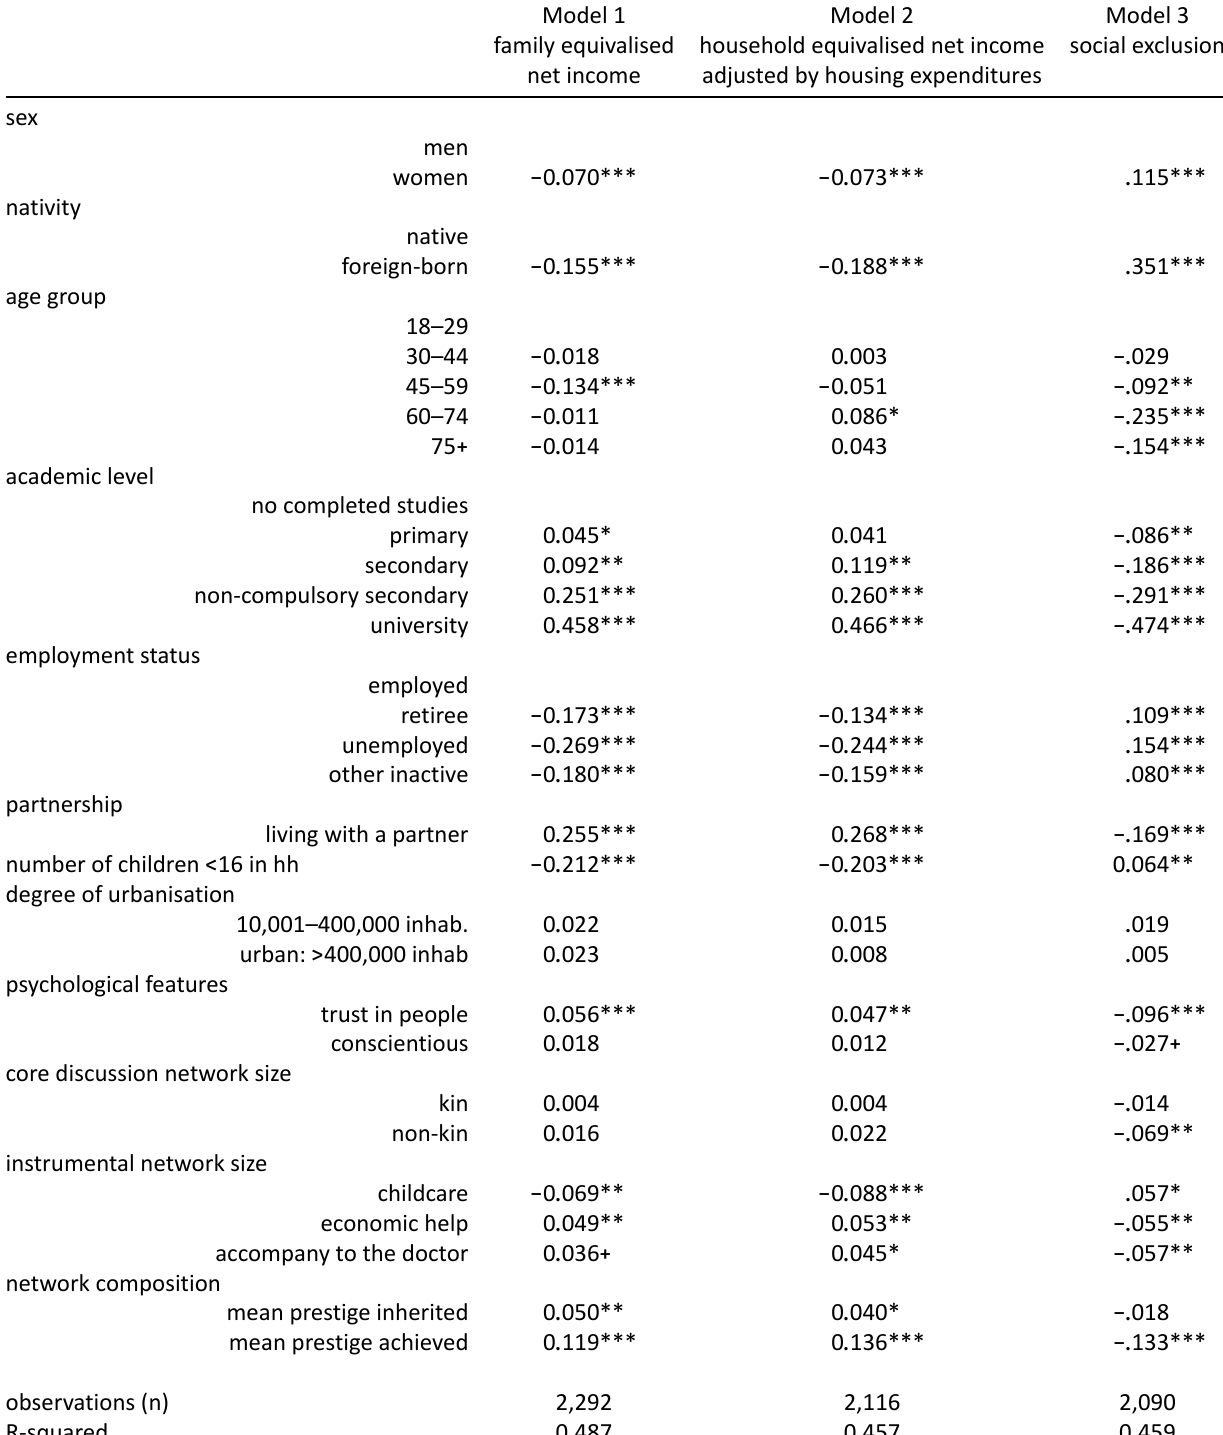
Table 2. Linear regression models (beta